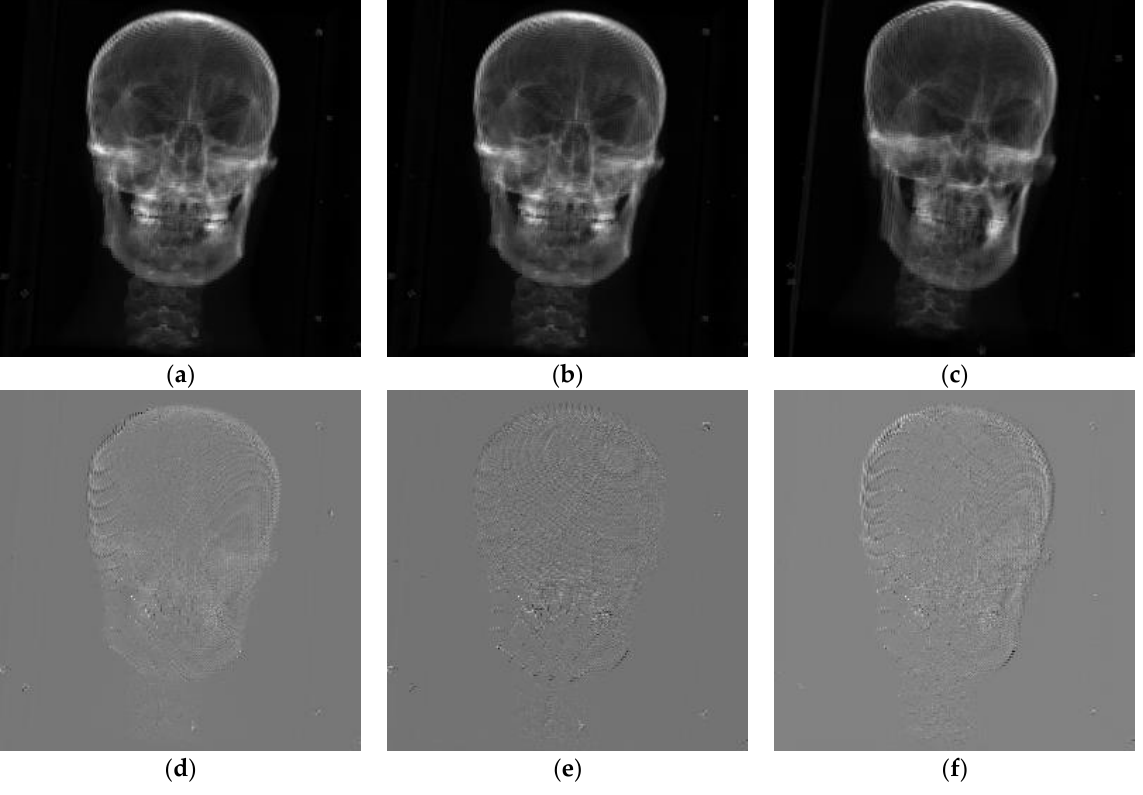
Figure 7. Experimental results of group 1. ( a ) DRR based on NCCS registration; ( b ) DRR after NCCL registration; ( c ) DRR based on NCC registration; ( d ) difference map after registration based on NCCS; ( e ) difference map after registration based on NCCL; ( f ) difference map after registration based on NCC.